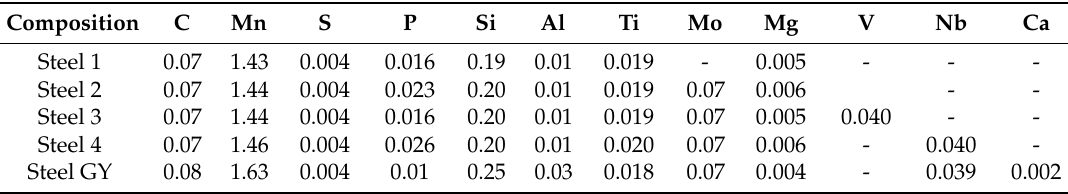
Table 1. The composition of test steel (wt